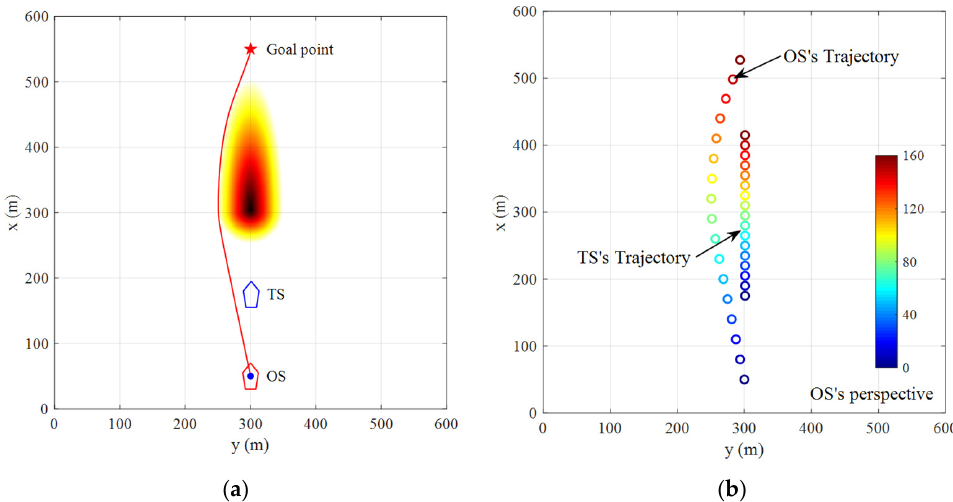
Figure 8. The planning results and the collision avoidance trajectories in the overtaking scenario. ( a ) The path planning results, ( b ) The collision avoidance trajectories.